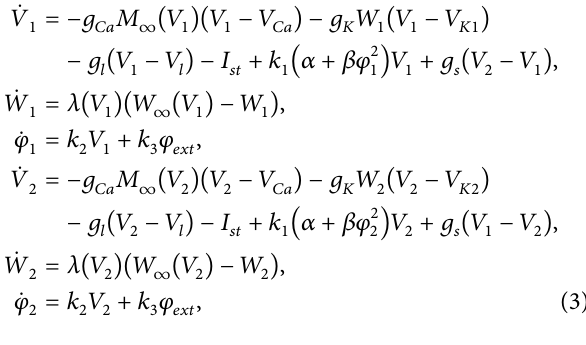
. Initial conditions are selected as (−0.1, 0, −2.5) and (−0.2, 0, −2.5) , 𝑠 = 1.0